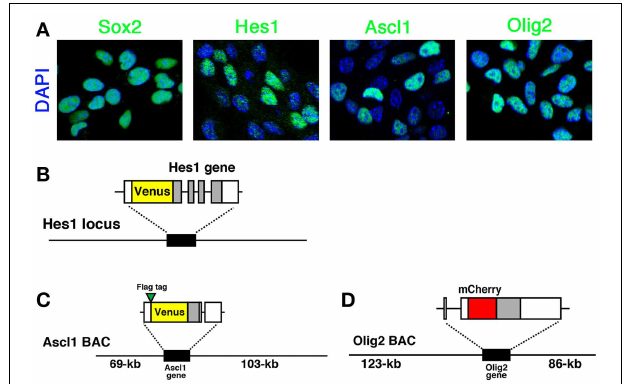
FIGURE 1 | Expression of bHLH factors in NS cells and fluorescent reporter-bHLH fusion constructs. (A) Self-renewing NS cells were immunostained with anti-Sox2, anti-Hes1, anti-Ascl1, and anti-Olig2 antibodies. Hes1, Ascl1, and Olig2 expression levels were variable while another NSC-specific factor, Sox2, was expressed at a relatively constant level. (B) Venus-Hes1 fusion knock-in mouse strain. (C) Venus-Ascl1 fusion BAC Tg mouse strain. (D) mCherry-Olig2 fusion BAC Tg mouse strain. Coding regions of bHLH factors are shown in gray. The pictures and graphs of this figure are reprinted from Supplementary Figures S1C,E; S2A; S6A–D of Imayoshi et al.